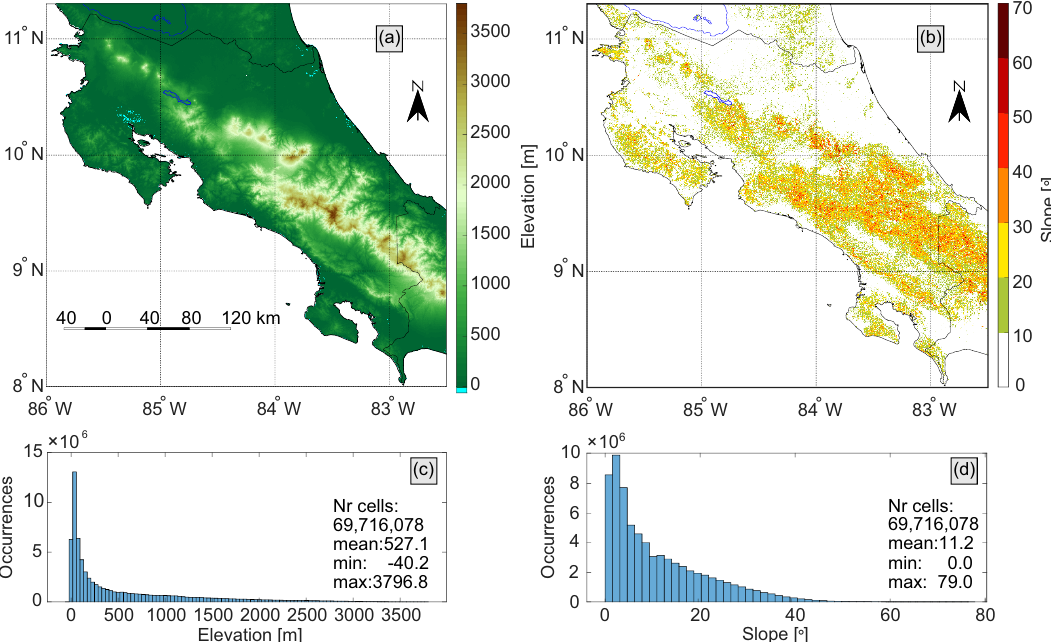
Figure 1. ( a ) Topography of the study area represented by 1 (cid:48)(cid:48) NASADEM. ( b ) Slopes in degrees computed from NASADEM. ( c ) Histogram of the NASADEM elevation distribution in the study area. ( d ) Histogram of the distribution of slopes in the study